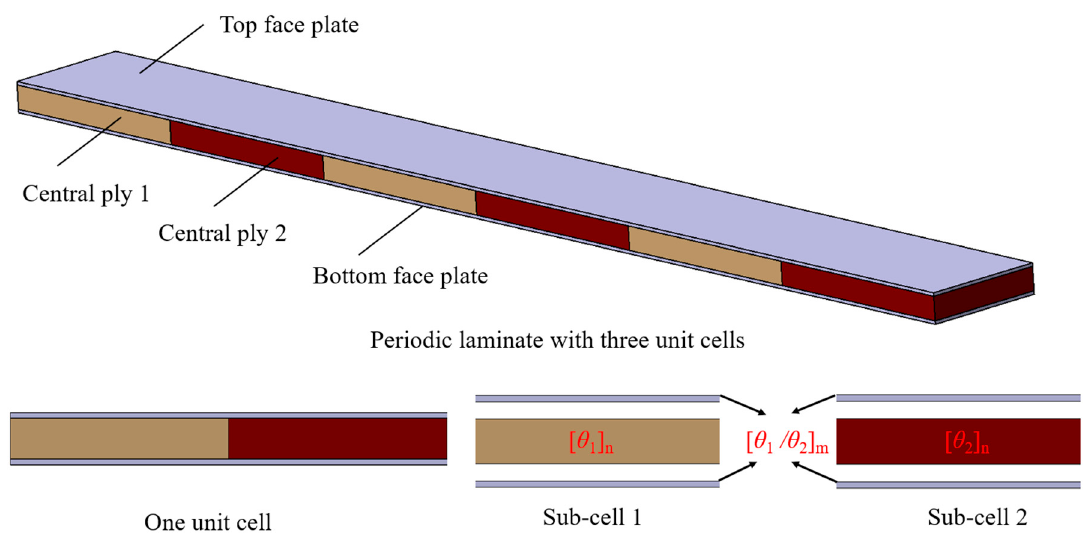
Figure 1. Schematic diagram of the CFRP laminate with one-dimensional periodic